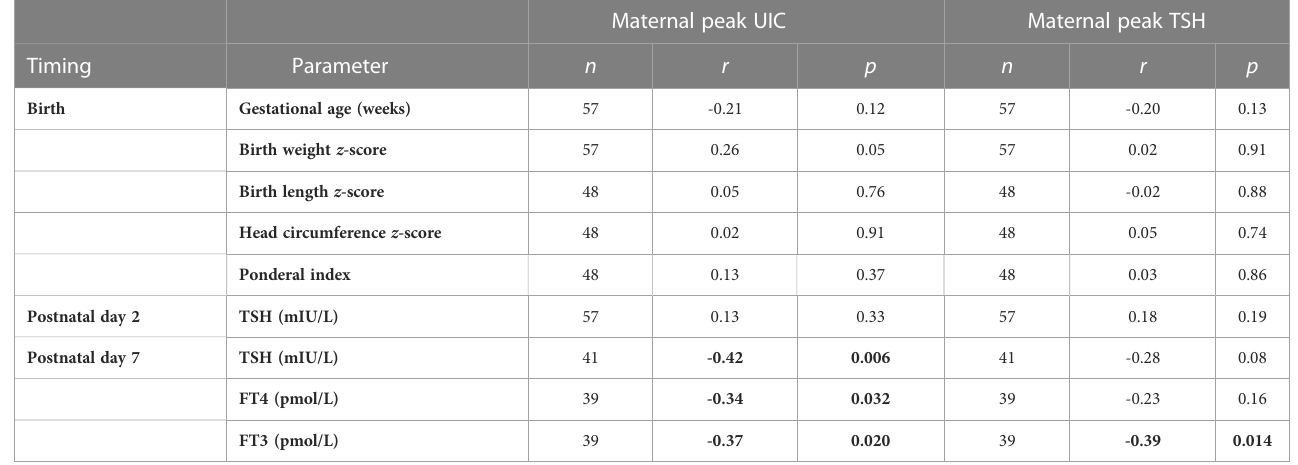
Data are the Pearson ’ s correlation coef fi cients (r) and respective p-values, with statistically signi fi cant associations at p<0.05 shown in bold. UIC values were log-transformed to approximate a normal distribution. FT3, free triiodothyronine; FT4, free thyroxine (tetraiodothyronine); and TSH, thyroid-stimulating hormone.